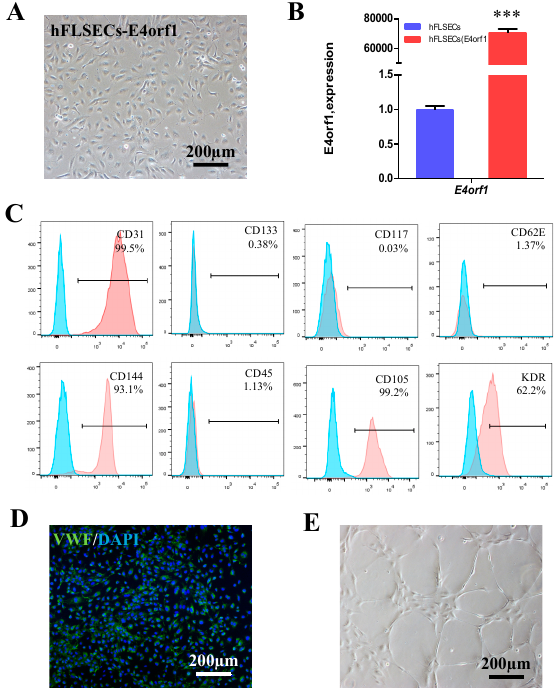
Figure 1. Identification of hFLSEC-E4orf1 feeders. ( A ) Representative phase contrast photomicrograph of hFLSECs-E4orf1. ( B ) qRT-PCR analysis of E4orf1 expression in hFLSECs after retrovirus infection and drug selection, with primary hFLSECs as a control. ( C ) Flow cytometric analysis of hFLSECs-E4orf1 for endothelial cell markers CD31, CD144, CD105, and KDR, stem cell marker CD117, progenitor cell marker CD133, endothelial activation marker CD62E, and hematopoietic marker CD45. ( D ) Immunostaining of vWF in hFLSECs-E4orf1. ( E ) Tube formation: hFLSECs-E4orf1 were plated in Matrigel for the formation of capillary-like structures. Scale bars: 200 μ m. Data represented as mean ± SEM. *** p < 0.001.